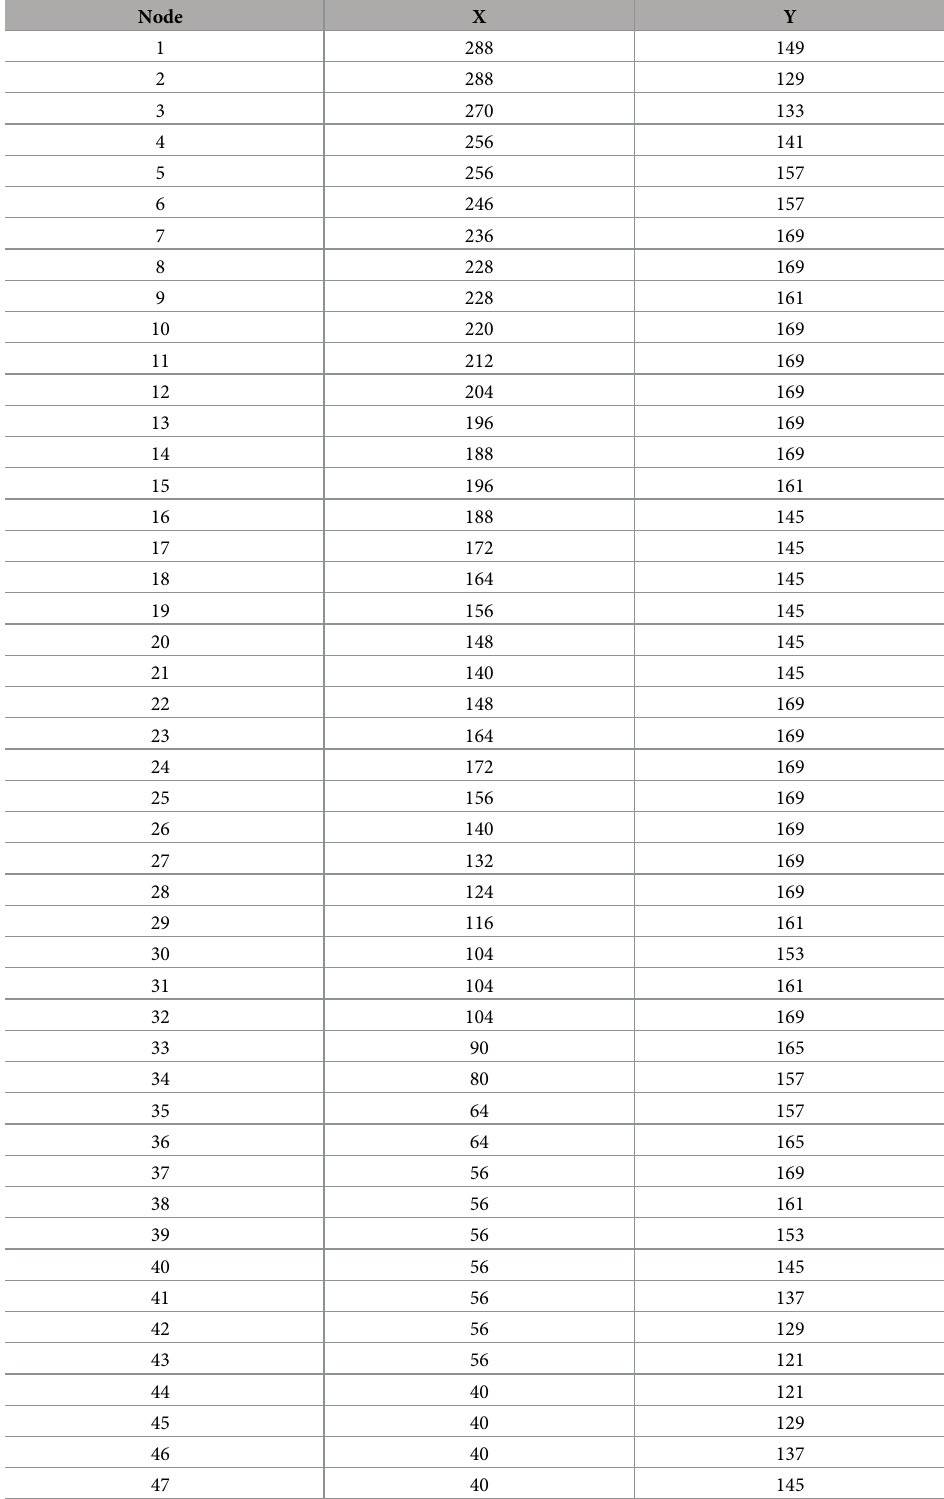
Table 15. Node coordinates with size n =